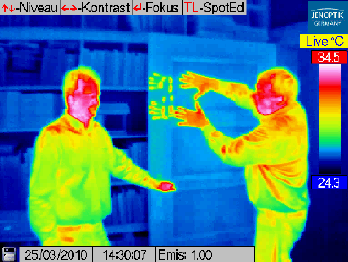
Figure 3: Visualization of thermal information captured with an InfraTec VarioCAM hr.